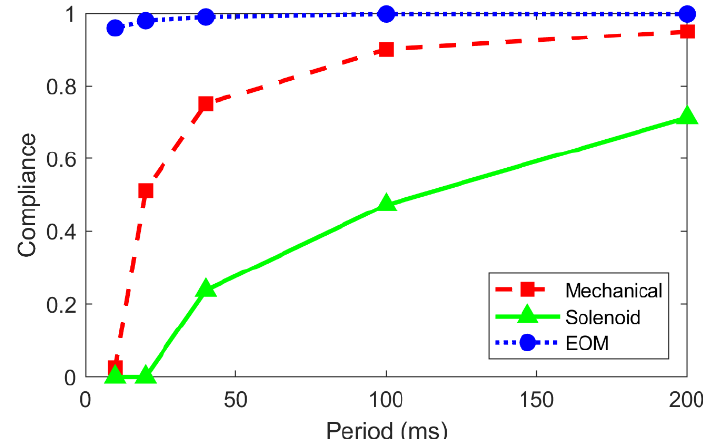
Figure 7. Compliance versus cycling period for each shutter.